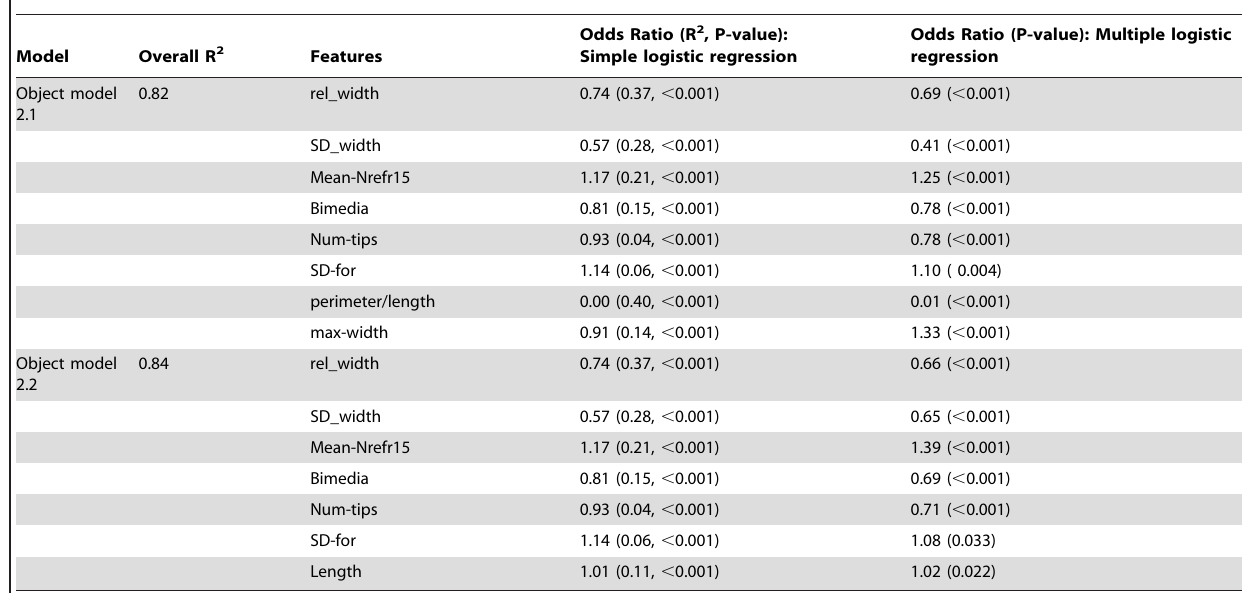
Table 4. Relevance of features from the best two variants object models, in a univariate and multiple variable logistic regression.